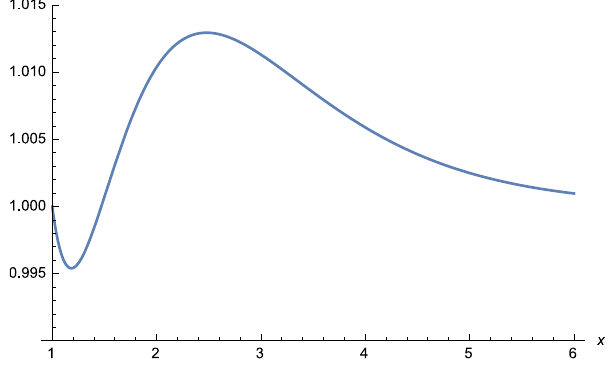
( x ) / F ( x ) for t = 1, with reference to Counterexample Figure 1. Plot of F Y t